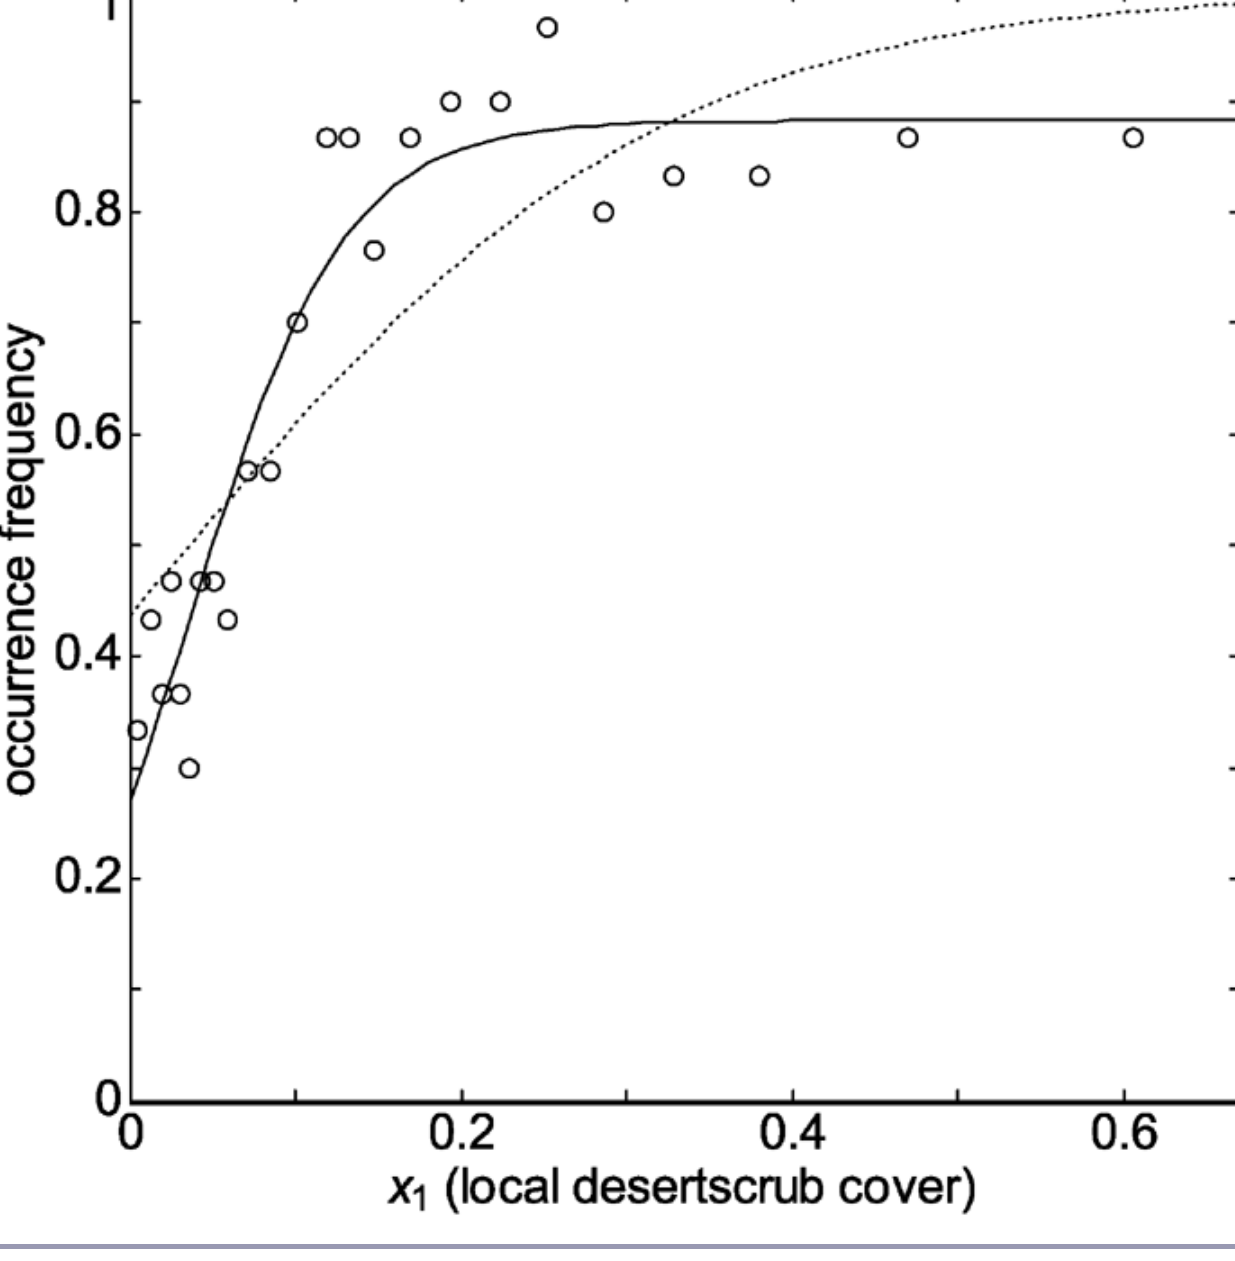
shown as a dotted line and M , a solid line to LOGISTIC ASYMP